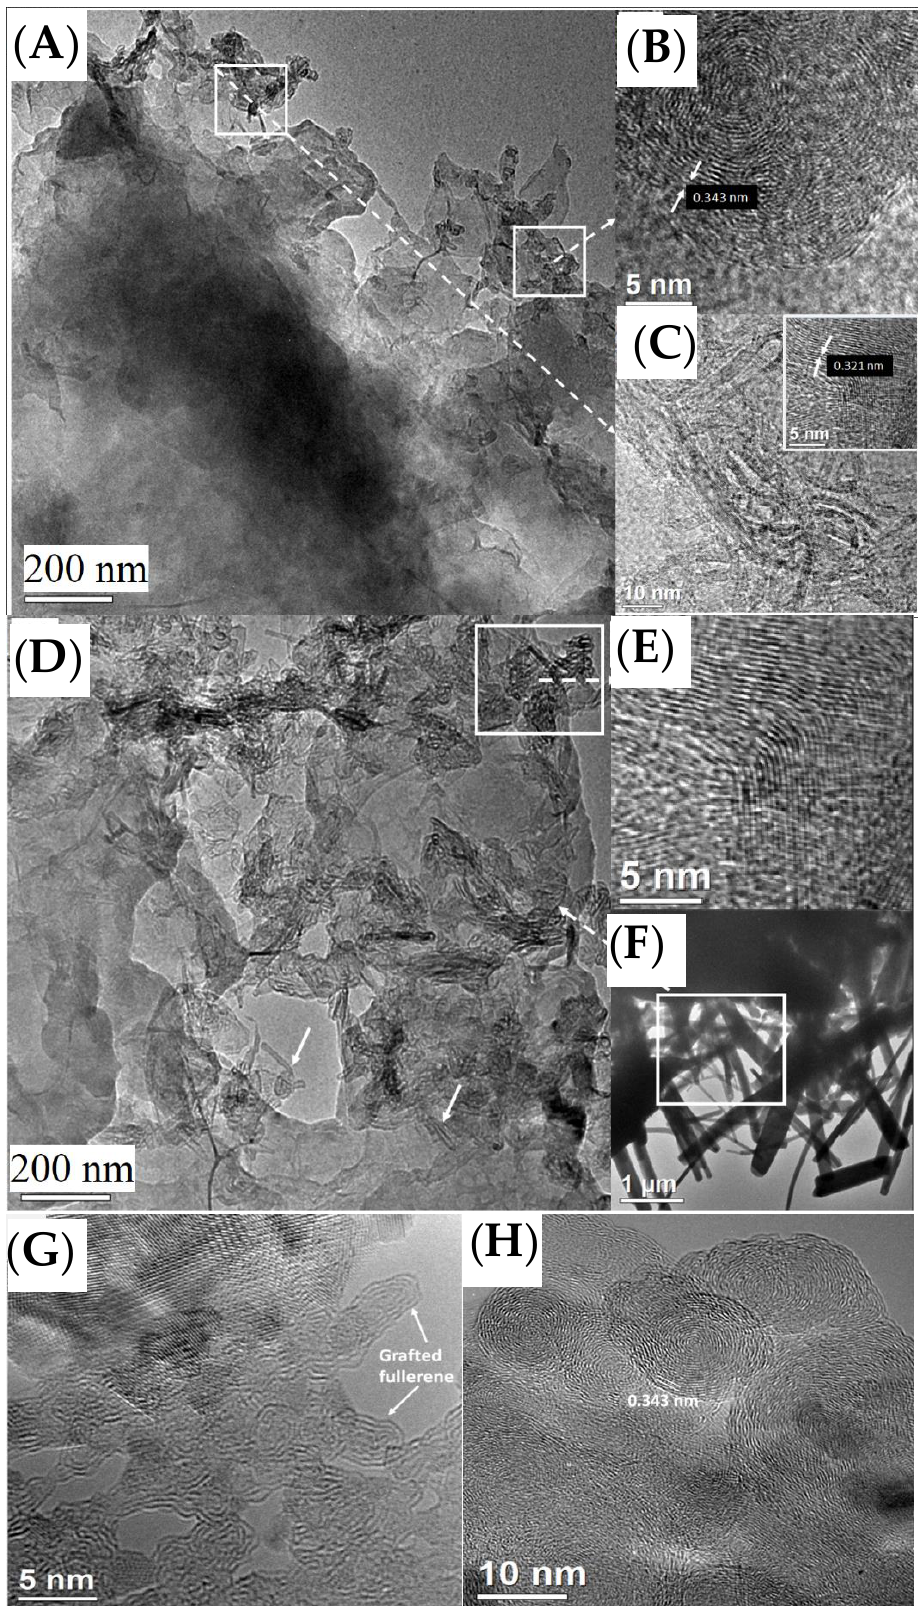
Figure 3. Transmission electron micrograph of ( A – C ) Ni50-Fe50 wt%, ( D – F ) Ni80-Fe20 wt%, and ( G , H ) Ni90-Fe10 wt% samples.